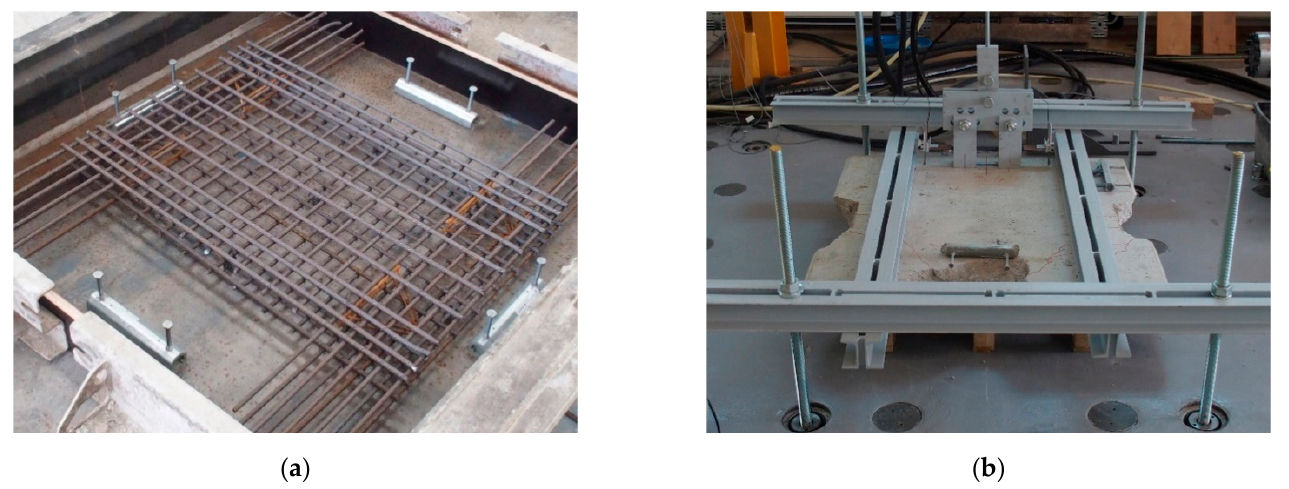
Figure 1. ( a ) Reinforcement arrangement—2 tension and 2 shear tests per slab; ( b ) Experimental setup. Table 2. Concrete mix design.